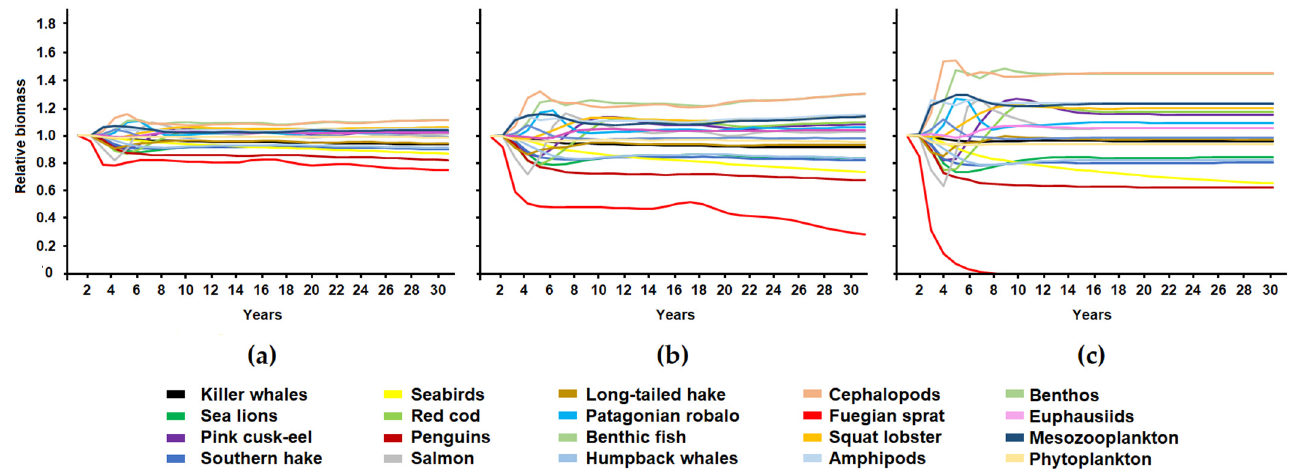
Figure 5. Changes in the relative biomass of the functional groups of the ecosystem in three simulated scenarios for Fuegian sprat showing fishing extraction of 10 ( a ), 25 ( b ), and 50% ( c ) of its biomass.